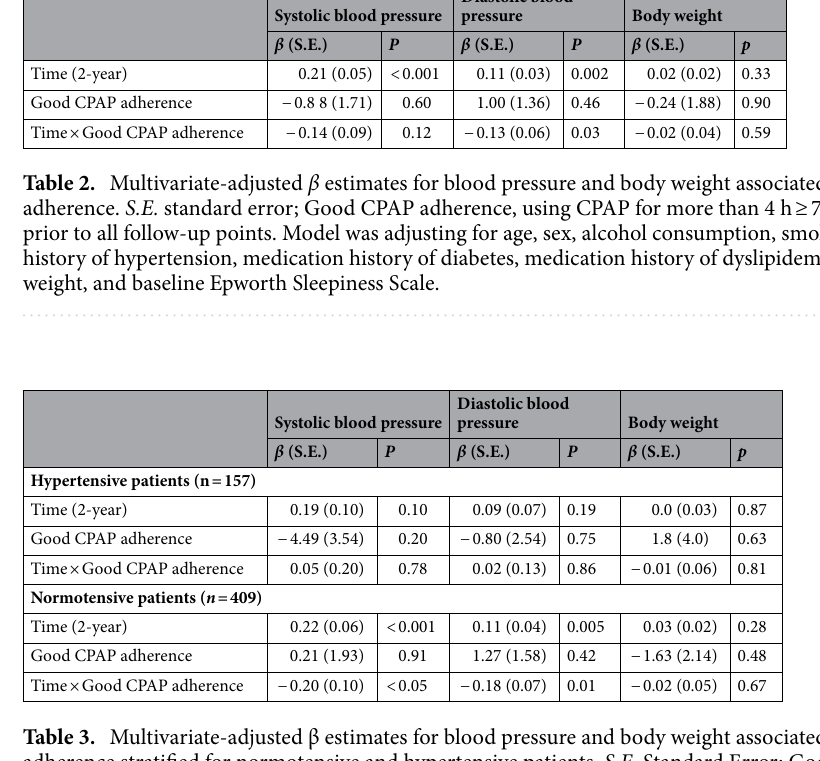
Table 3. Multivariate-adjusted β estimates for blood pressure and body weight associated with CPAP adherence stratified for normotensive and hypertensive patients. S.E. Standard Error; Good CPAP adherence, using CPAP for more than 4 h ≥ 70% of the 30 days prior to all follow-up points. Model was adjusting for age, sex, alcohol consumption, smoking, medication history of hypertension, medication history of diabetes, medication history of dyslipidemia, baseline body weight, and baseline Epworth Sleepiness Scale.